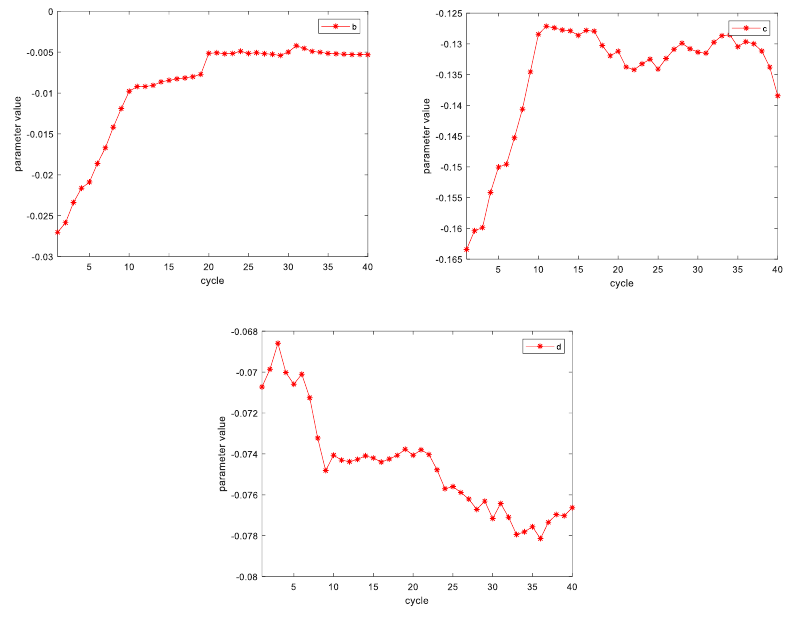
Figure 8. Estimation process of B6 battery parameters.